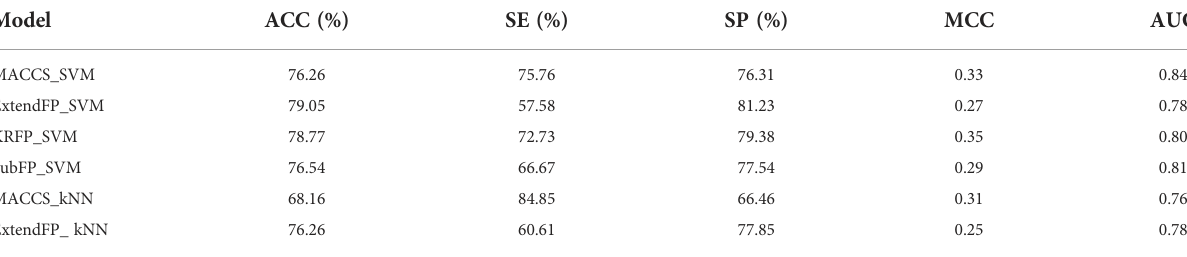
TABLE 3 Performances of best performed models on validation set. Model